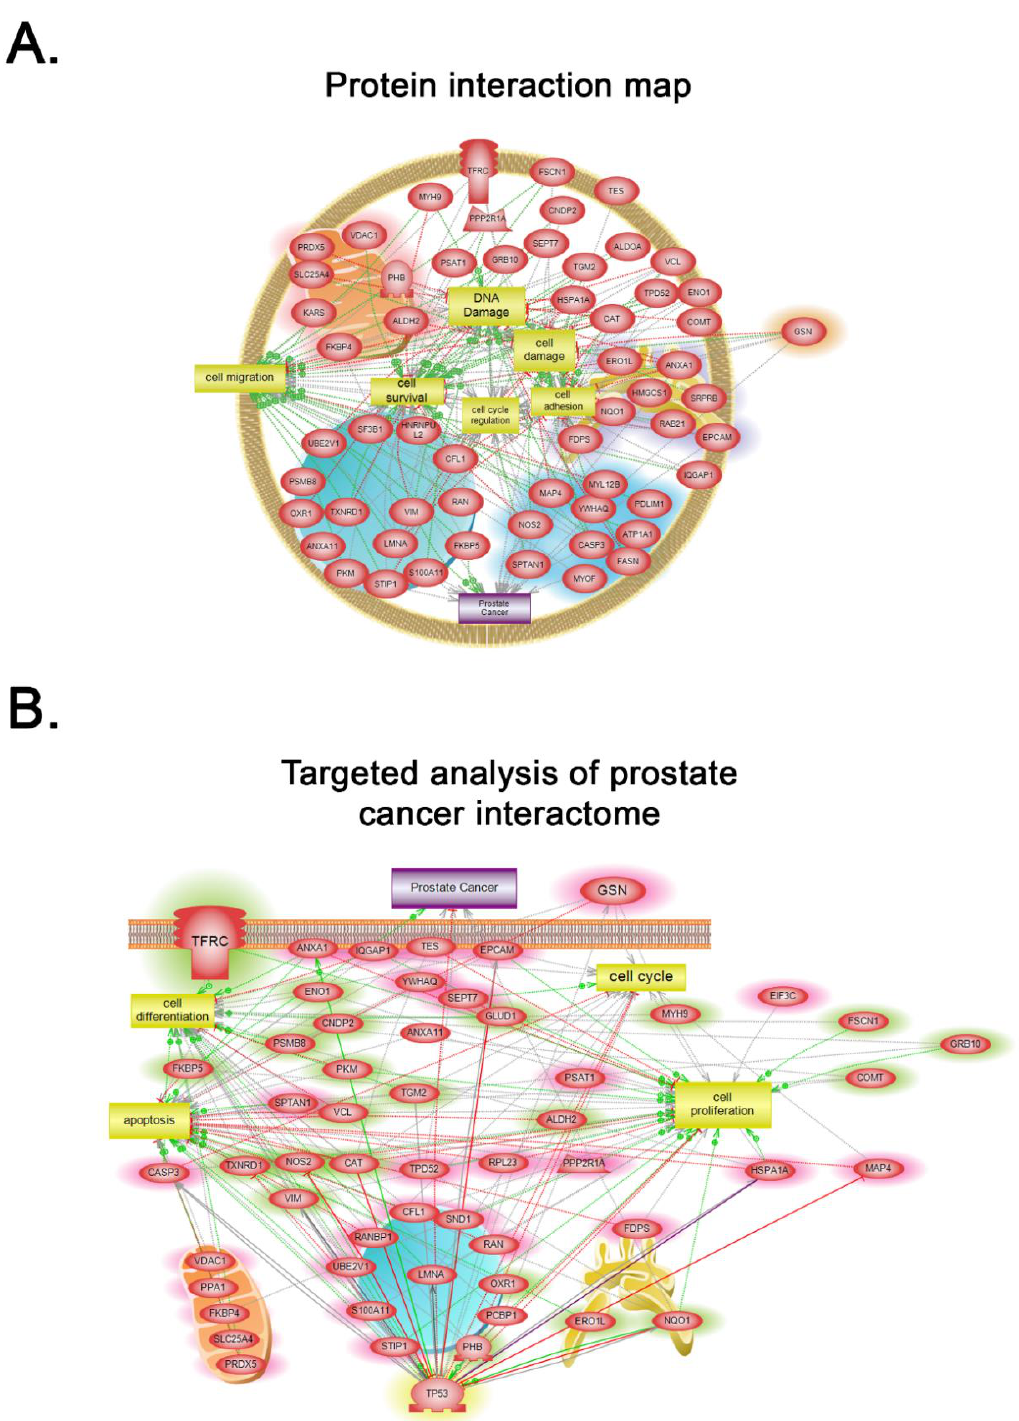
Figure 5. Systems biology analysis. ( A ) Biologically statistically significant protein interaction map showing enrichment of biological functions and pathways in PLum-AI cells that are central to cell migration, cell cycle regulation, cell damage, cell survival, DNA damage, and cell adhesion (Supporting Information Table S2). ( B ) Targeted analysis of prostate cancer interactome in PLum-AI cells vs. PLum-AD cells revealed dysregulation of proteins involved in cell di ff erentiation, cell proliferation, cell cycle, and apoptosis (Supporting Information Table S3). Relationships among the di ff erentially expressed proteins in PLum-AI cells vs. PLum-AD cells were determined using Elsevier’s Pathway Studio version 10.0 (Ariadne Genomics, Elsevier) and the Ariadne ResNet database [35,36].